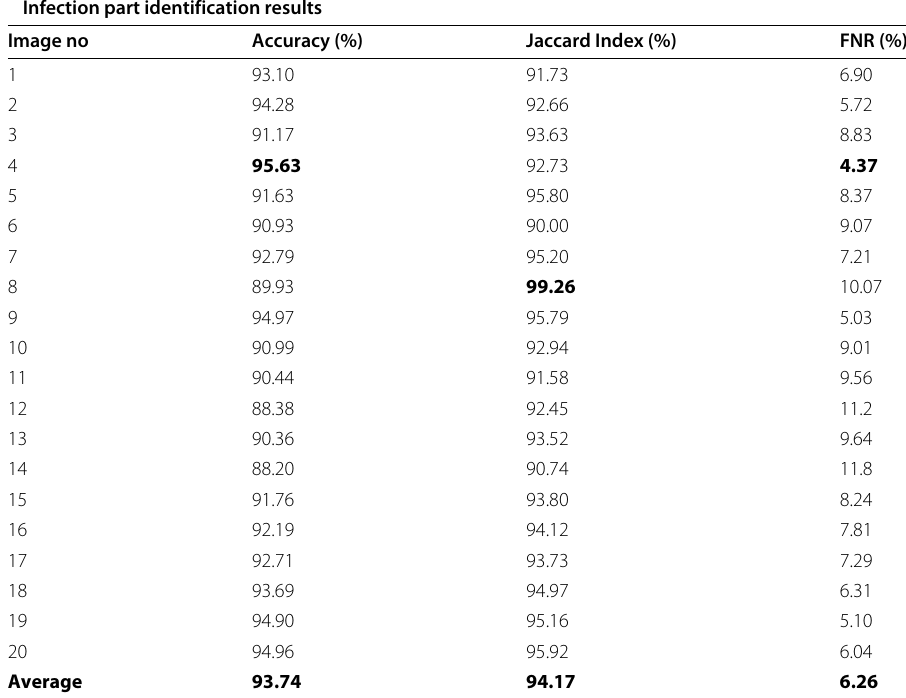
Table 2 Performance results of the proposed identification of infection parts in the fruits and plants Infection part identification